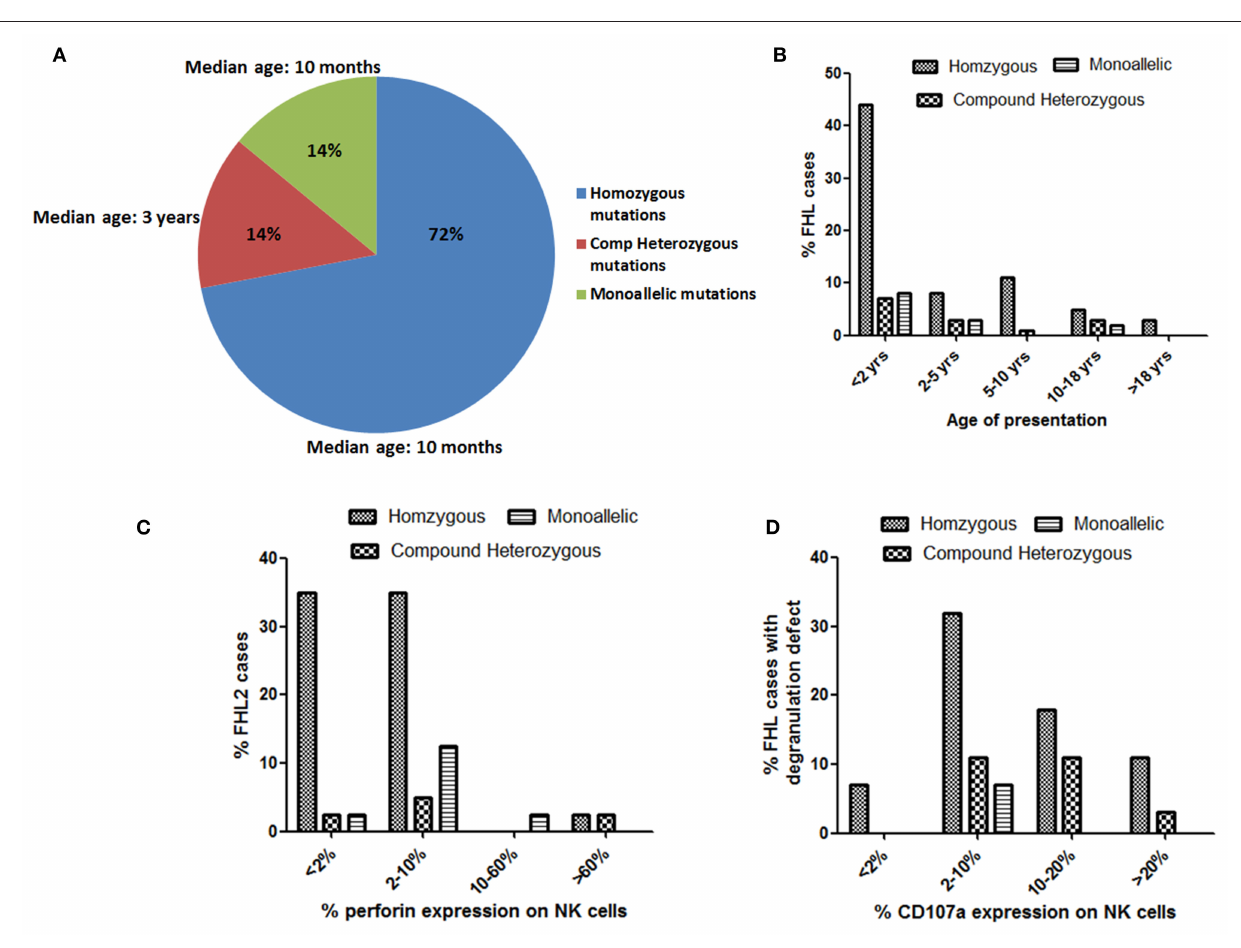
knowledge, this is one of the largest studies on the spectrum of FHL in Indian population. This study also evaluates the utility of flow cytometry based assays for efficient diagnosis of FHL patients.